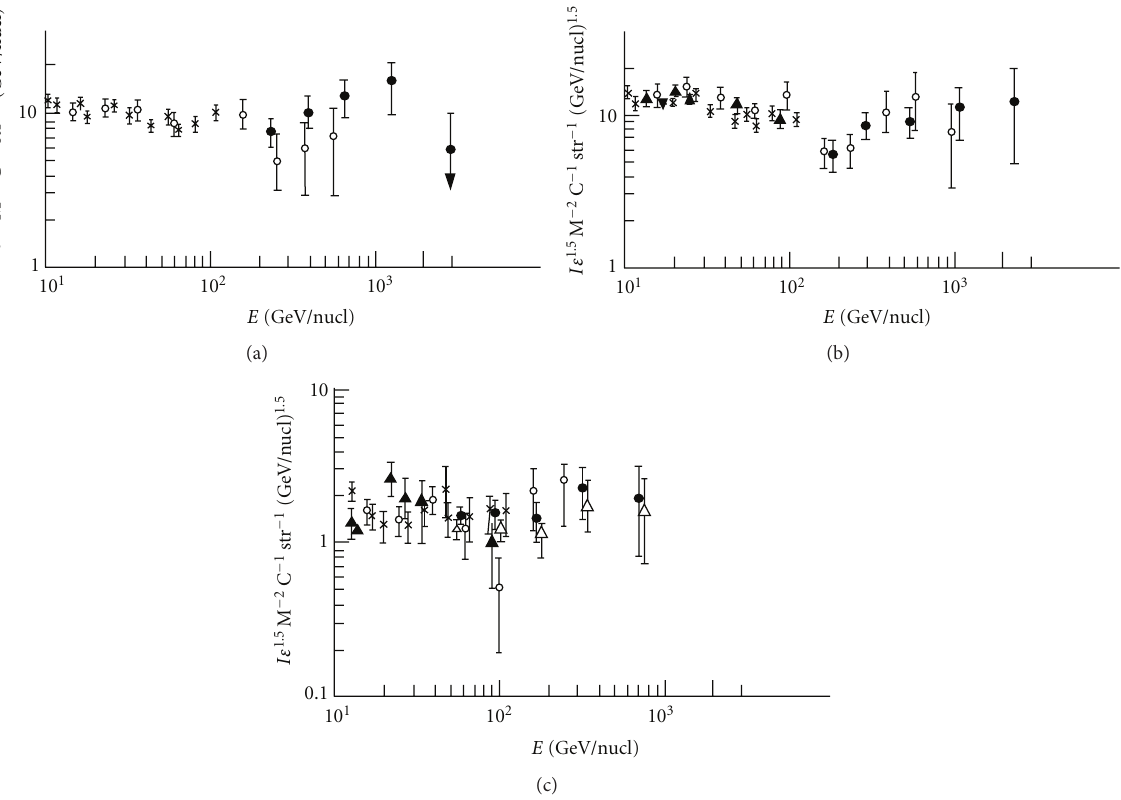
Figure 7: Energy spectra of carbon C (a), oxygen O (b), and iron Fe (c) nuclei at high energies according to the results of flights equipped with the complex device